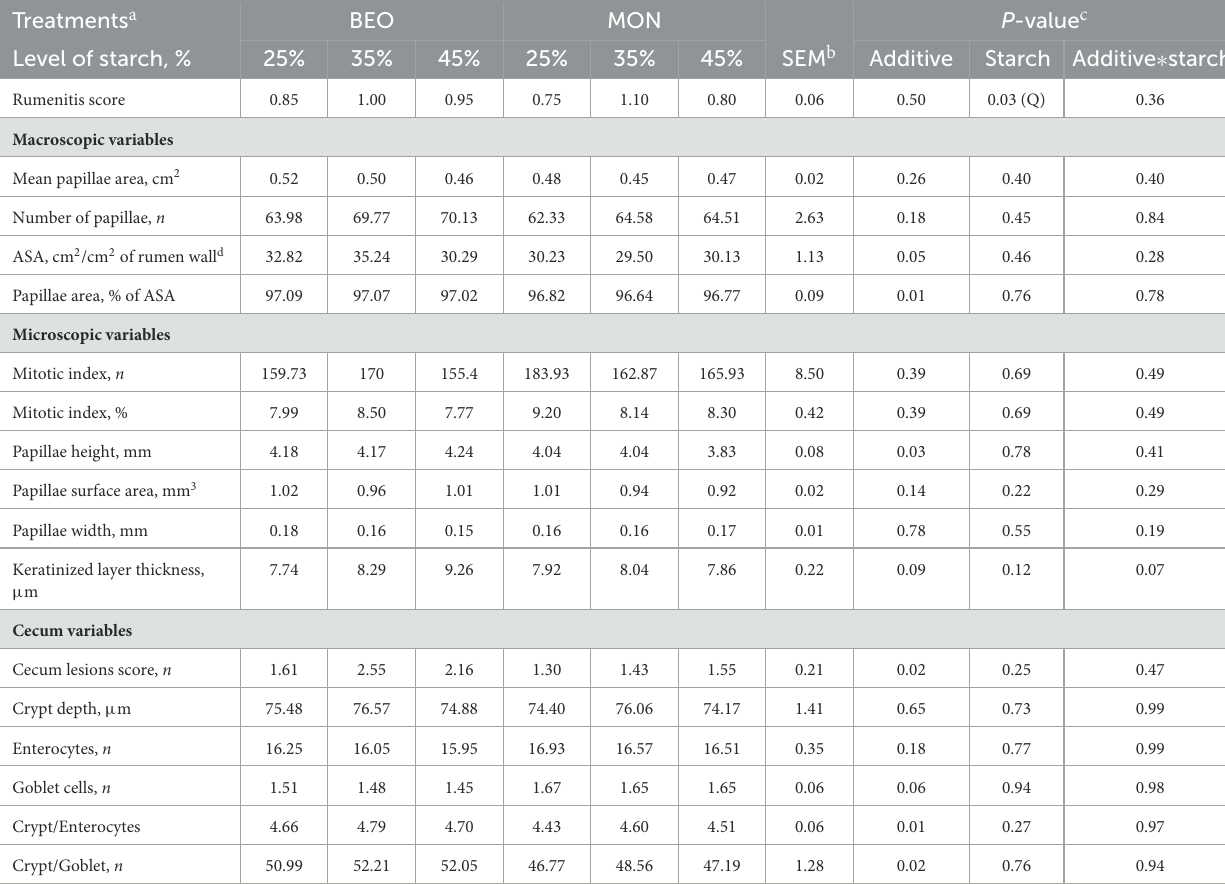
TABLE 6 Levels of starch associated with blend of essential oils or sodium monensin on rumen and cecum morphometrics of Nellore yearling bulls. Treatments a BEO MON P- value c Level of starch, % 25% Additive Starch Additive ∗